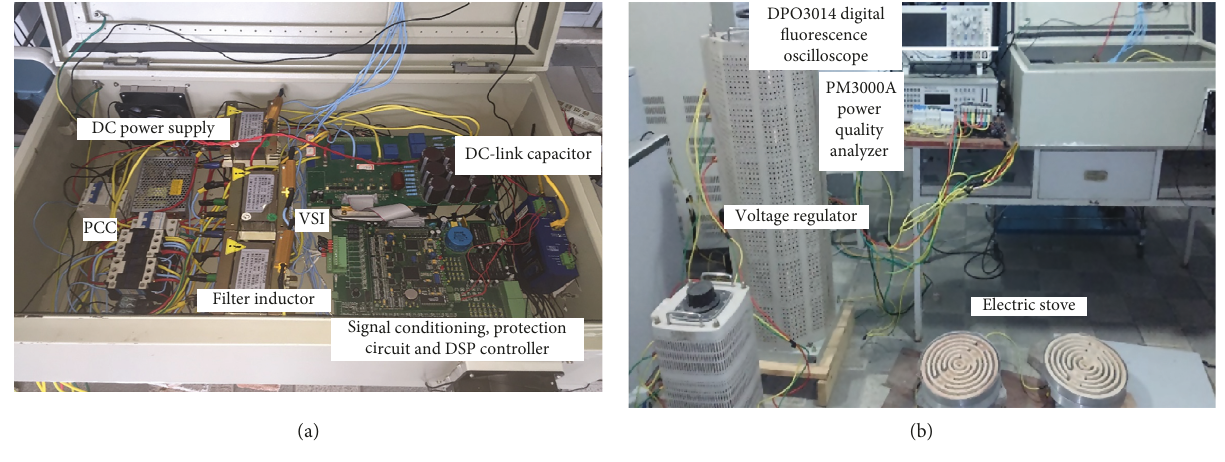
Figure 20: Experimental setups of SAPF.